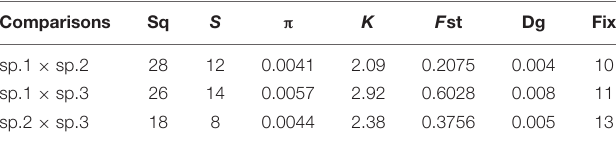
TABLE 3 | Comparison of ITS1 sequences between species of the AF complex in Brazil. Comparisons